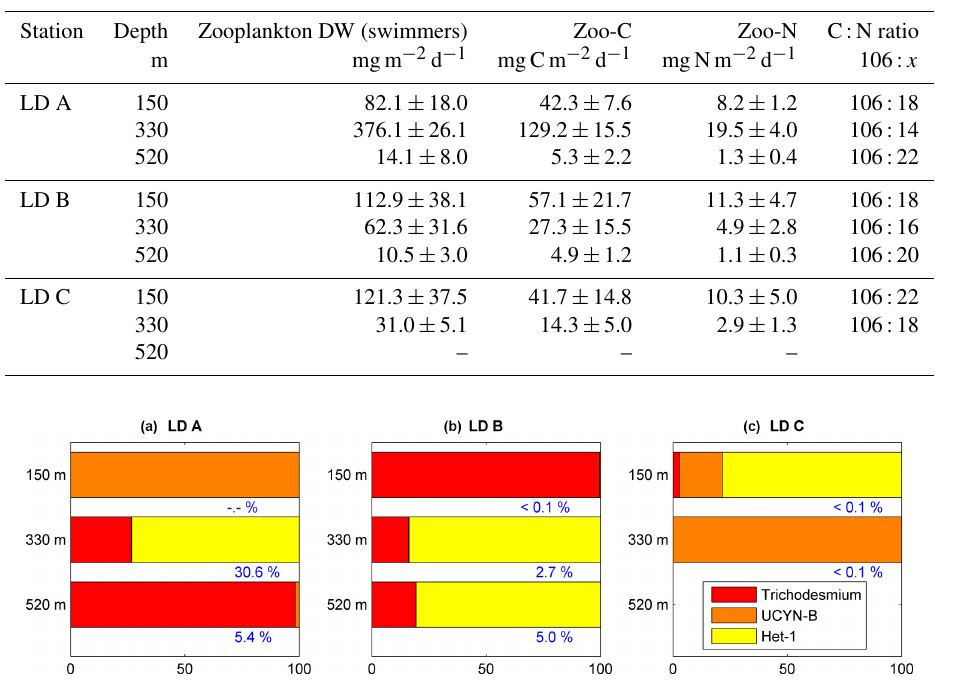
Table 4. Zooplankton sediment traps data at the three LD stations. Depth of sampling, mean dry weight (DW) zooplankton recovered in the traps, and C and N associated with zooplankton.